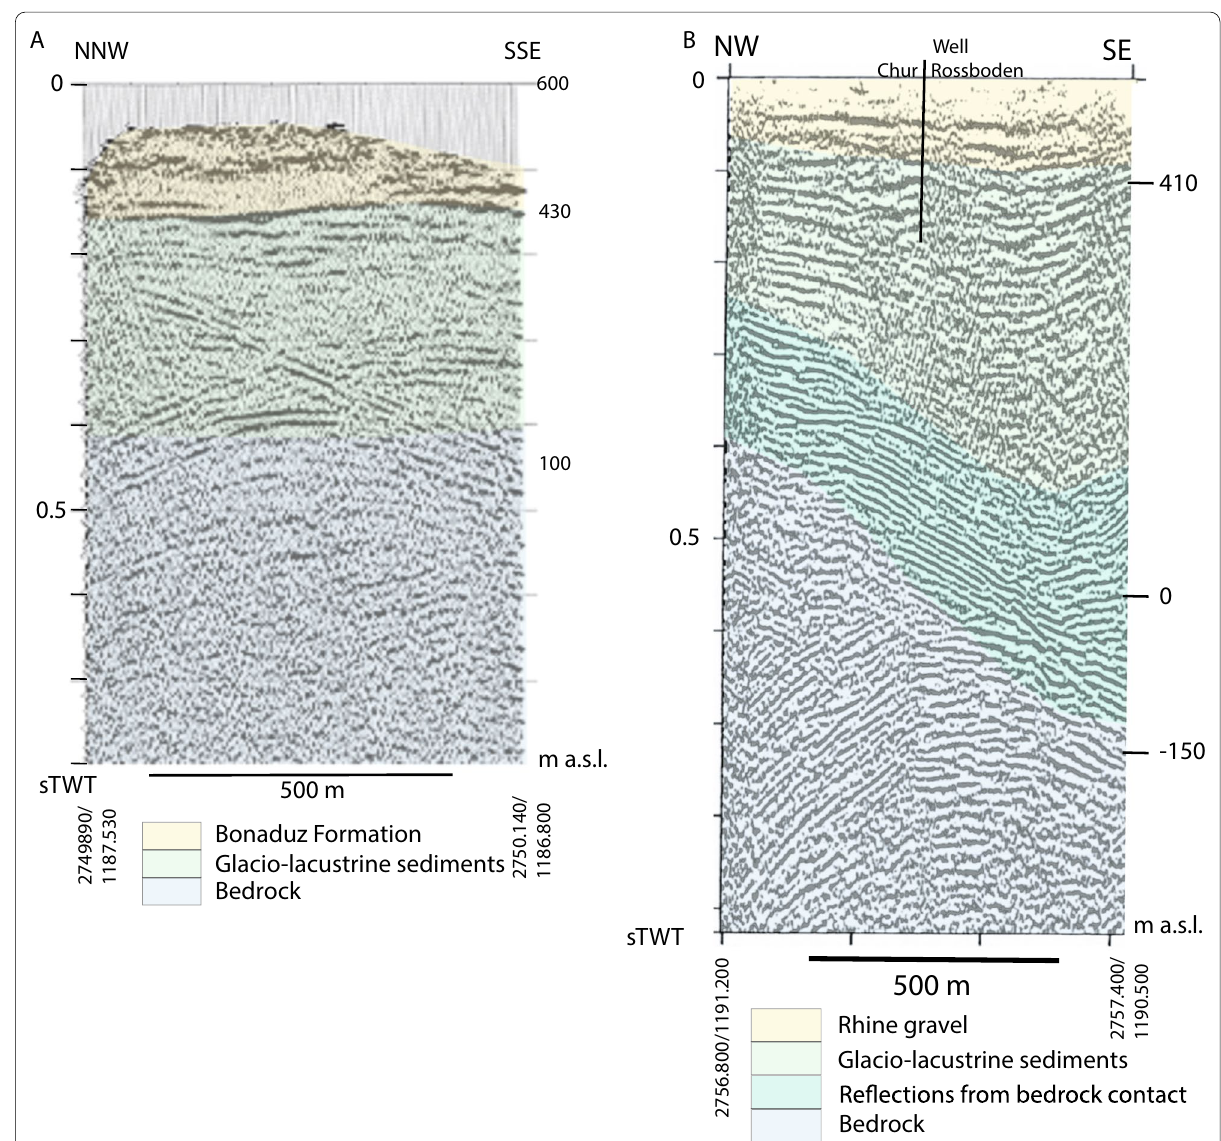
Fig. 3 Seismic lines across the Rhine Valley illustrating glacial overdeepening (modified from Pfiffner et al., 1997). A Seismic line Bonaduz shows a classic bow tie pattern originating from the U-shaped bedrock surface. The boundary between the Bonaduz Formation and the glacio-lacustrine sediments is calibrated by a well off the line. B Seismic line Chur Rossboden. The boundary between Rhine gravel and glacio-lacustrine sediments is calibrated by a well. The SE dipping reflections originated from the bedrock surface and overprint a bow tie structure caused by the U-shaped